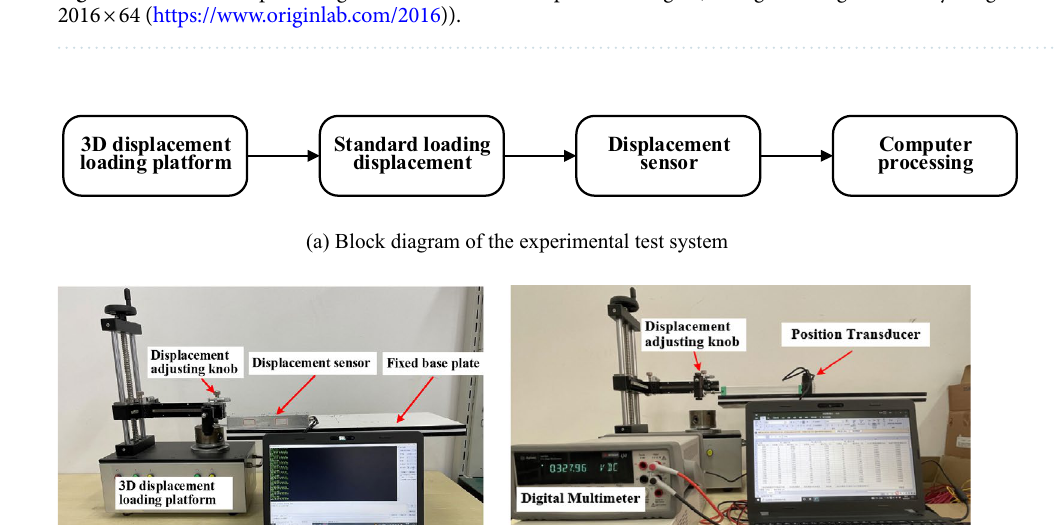
Computer processing